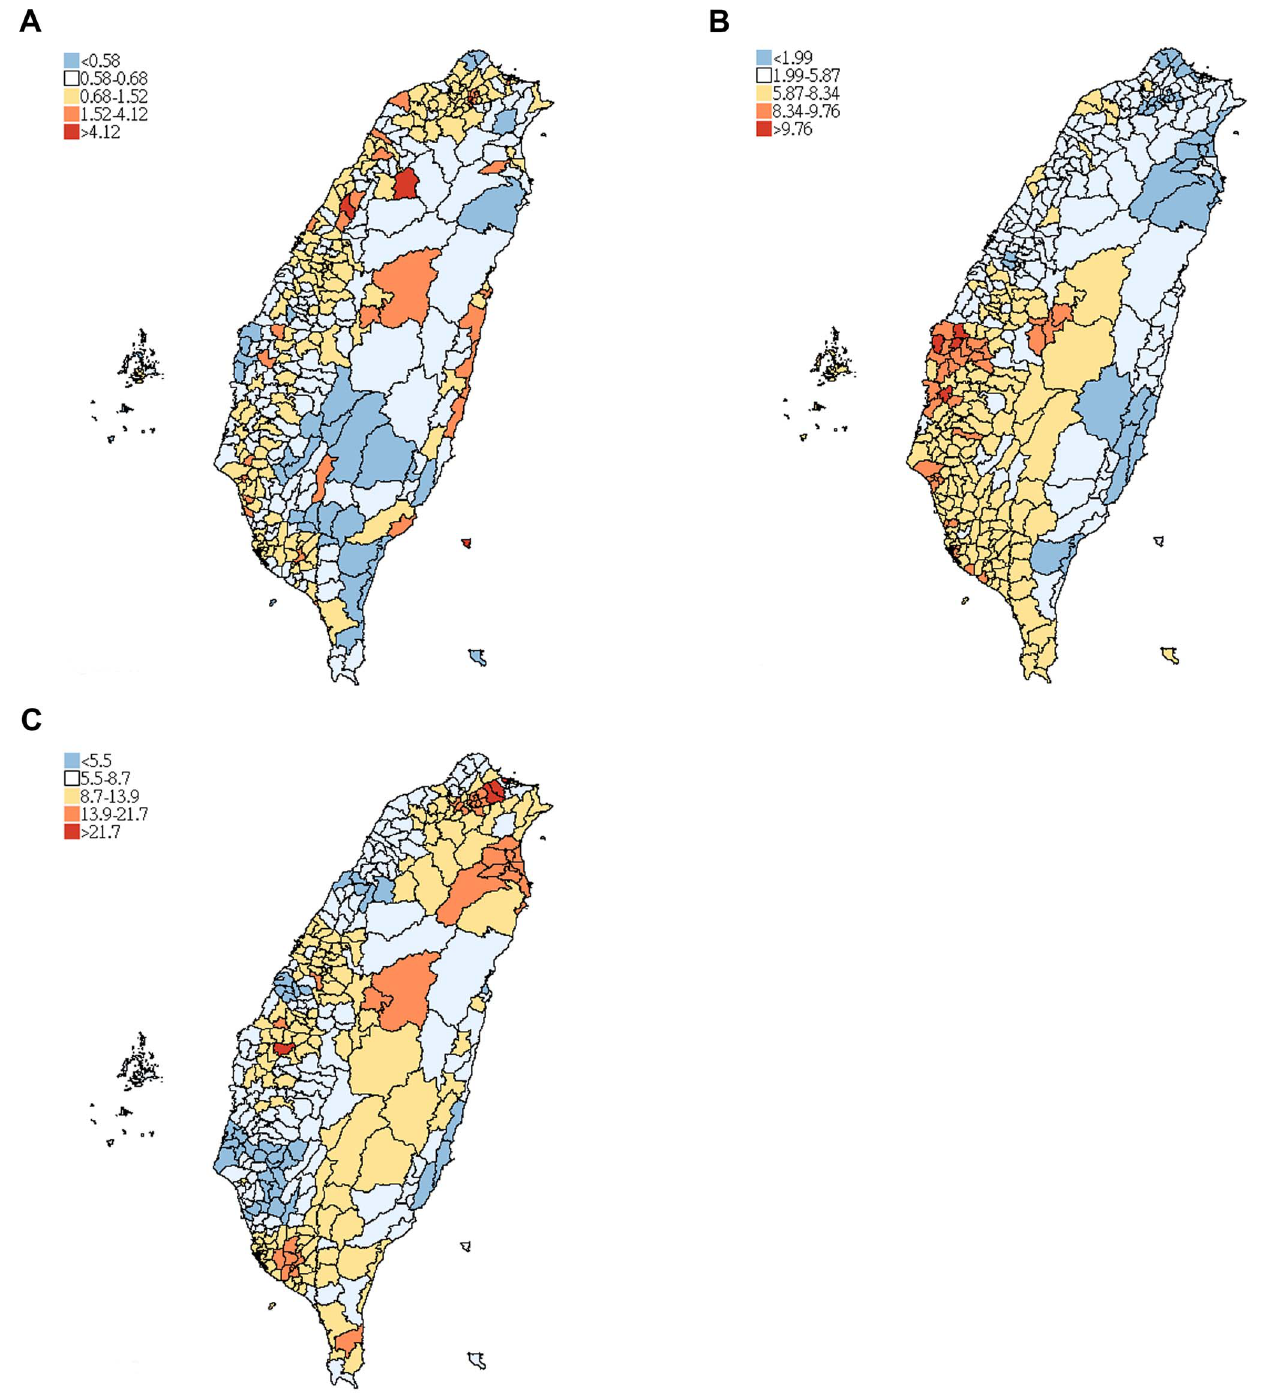
Figure 1. Map of multiple sclerosis age-standardized incidence ratios (ASIR, 1997–2008), soil arsenic (As, 1986–2002) and lead (Pb, 1986–2002) concentrations in Taiwan. (A) ASIR for MS. (B) As (mg/kg). (C) Pb